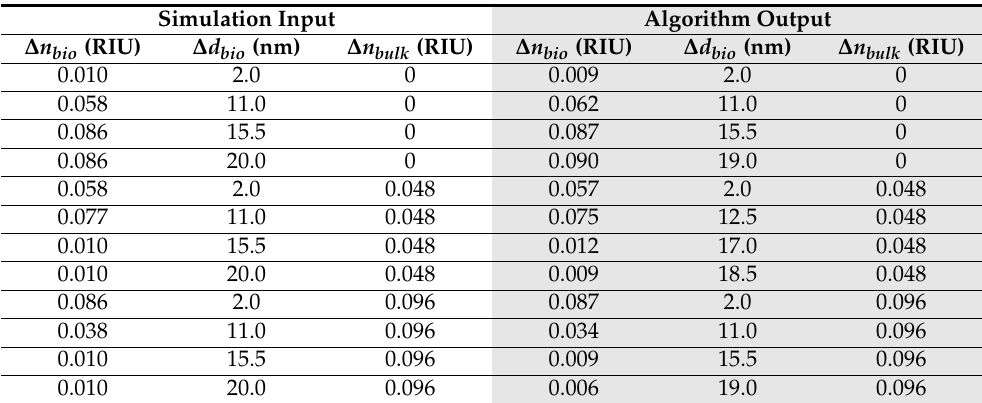
Table 1. Simulation Input and Algorithm